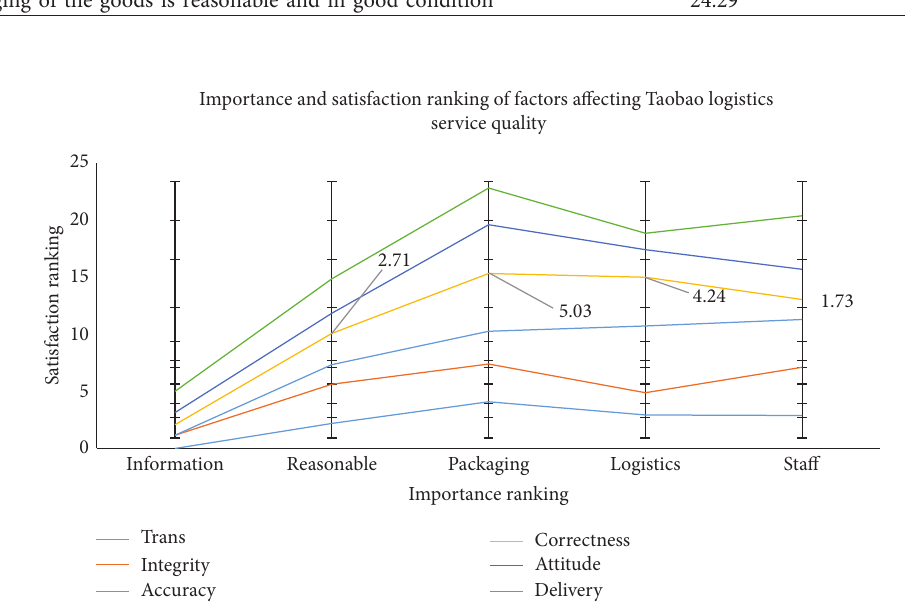
Figure 9: Importance and satisfaction ranking of factors affecting Taobao logistics service